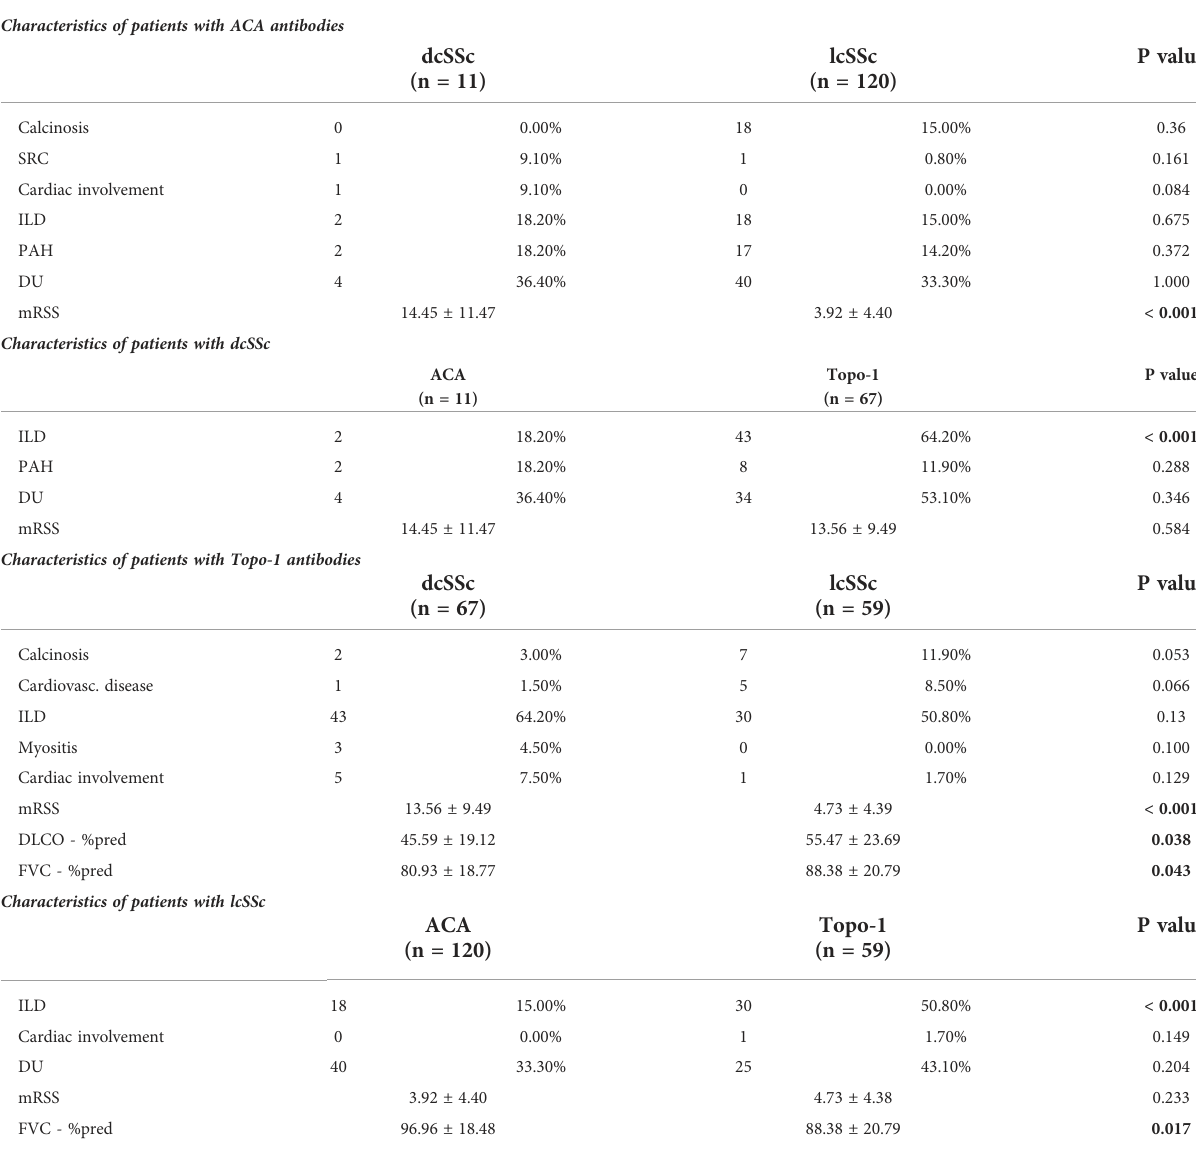
TABLE 4 Characteristics of patients with inverted